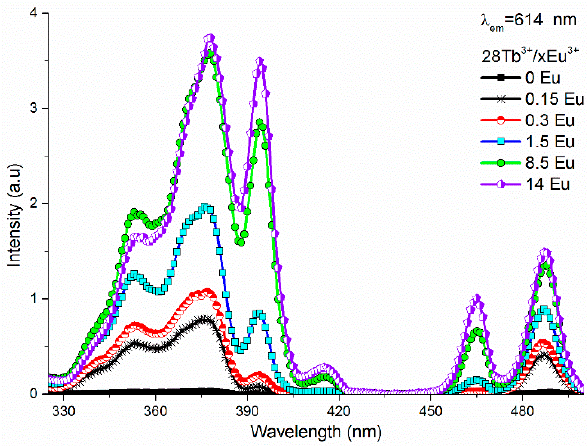
Figure 3. Excitation spectra of the Tb 3 + / Eu 3 + -codoped ceramic phosphor plate monitored at 614 nm.